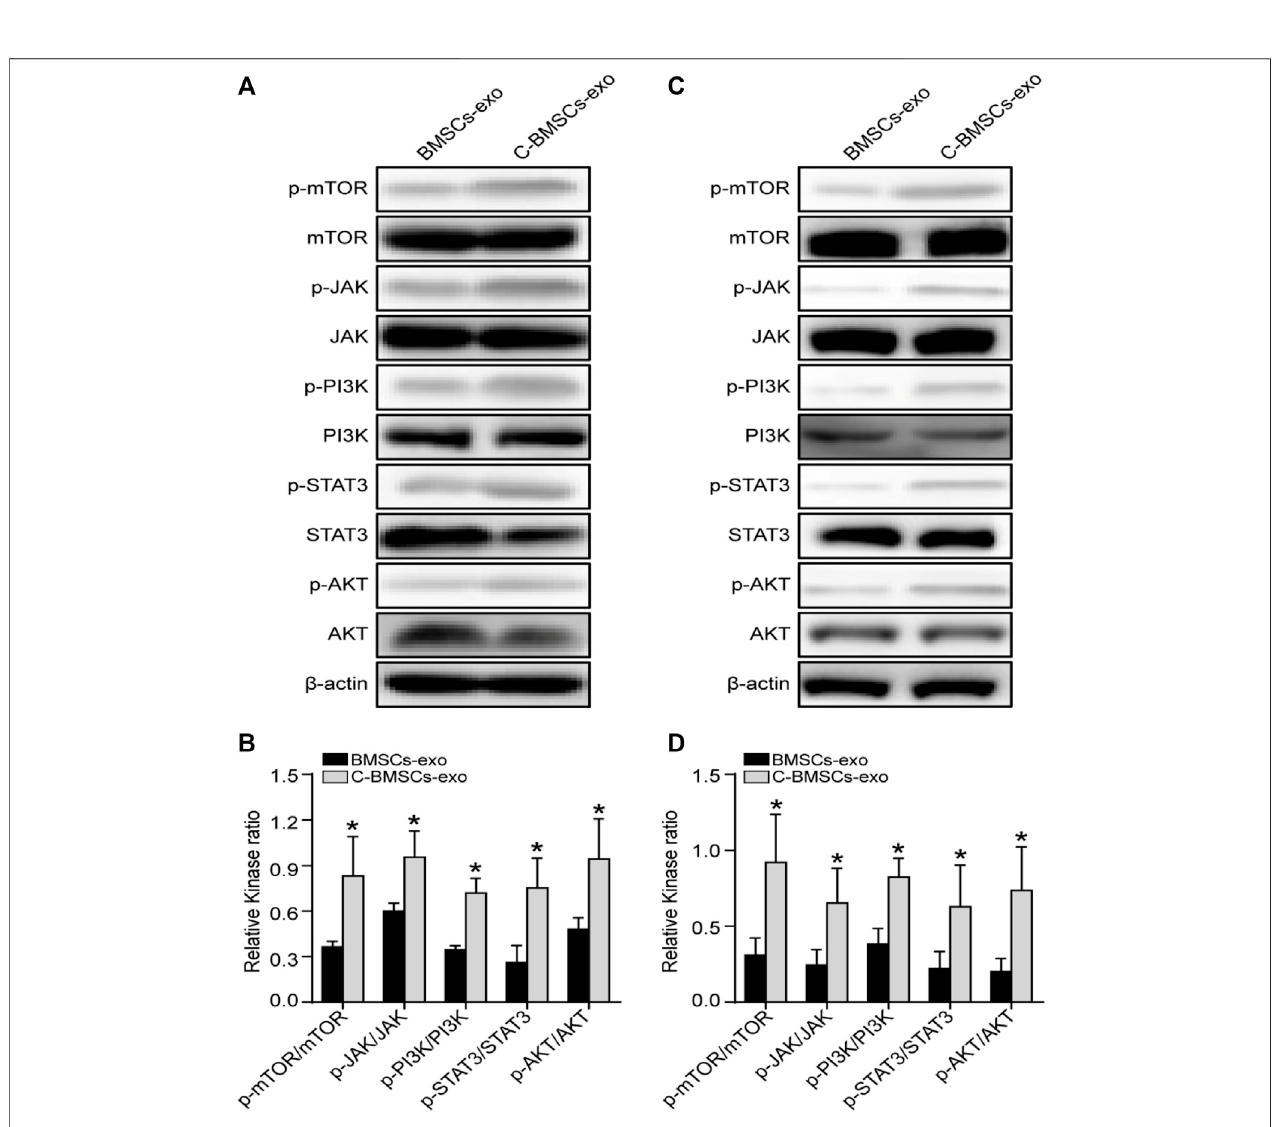
FIGURE 8 | Assessment of the in vitro and in vivo effects of CTF1 in the context of BMSC-exo treatment. (A) Western blotting was used to assess JAK, p-JAK, PI3K,p-PI3K,AKT,p-AKT,mTOR,p-mTOR,STAT3,andp-STAT3levels invitro inthecontextofCTF1expressioninBMSCs-exo. (B) Statisticalanalysesdemonstrating signi fi cantincreasesinJAK/PI3K/mTOR/STAT3phosphorylationinC-BMSC-exotreatmentconditionsrelativetoBMSC-exotreatment( n =3). (C) Westernblottingwas used to assess JAK, p-JAK, PI3K, p-PI3K, AKT, p-AKT, mTOR, p-mTOR, STAT3, and p-STAT3 levels in vivo in the context of CTF1 expression in BMSC-exo treatment. (D) Statistical analyses exhibiting signi fi cant increases in JAK/PI3K/mTOR/STAT3 pathway activation in the C-BMSCs-exo group relative to the BMSC-exo group ( n = 3). * p < 0.05.